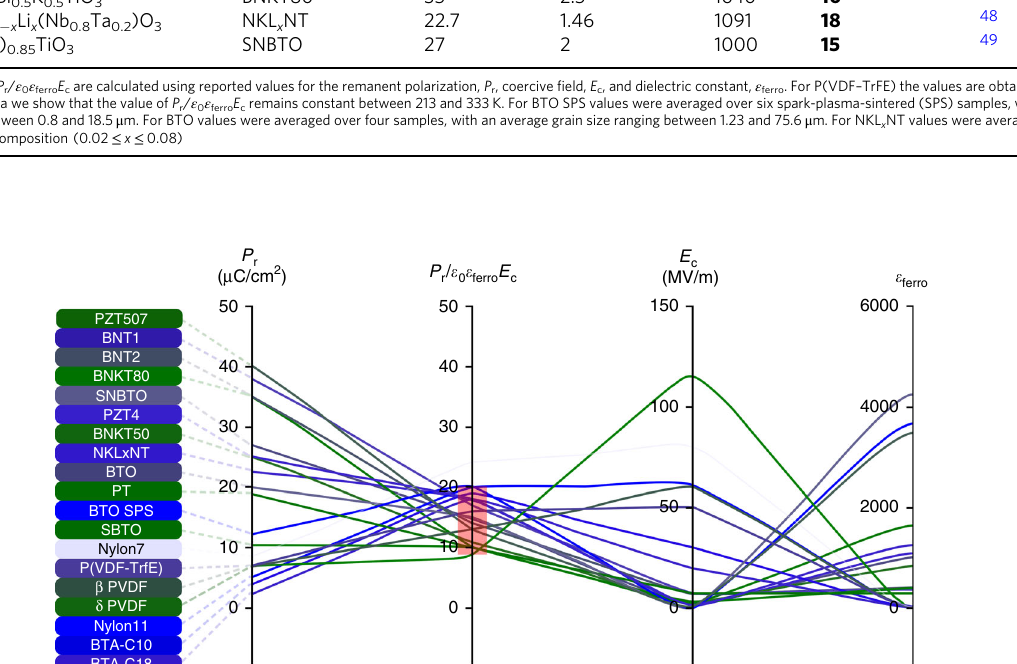
Fig. 6 Parallel coordinate plot of P r / ε 0 ε ferro E c . The remanent polarization, P r , coercive fi eld, E c , dielectric constant, ε ferr ο , and the ratio P r / ε 0 ε ferro E c , for various ferroelectric materials, as summarized in Table 1, are presented in parallel coordinates. Lines are guides to the eye and are colored in a gradient from green to blue for clarity. Despite the fact that the values of coercive fi eld, remanent polarization and dielectric constant vary by several orders of magnitude, for all ferroelectric materials considered here a comparable value for P r / ε 0 ε ferro E c is